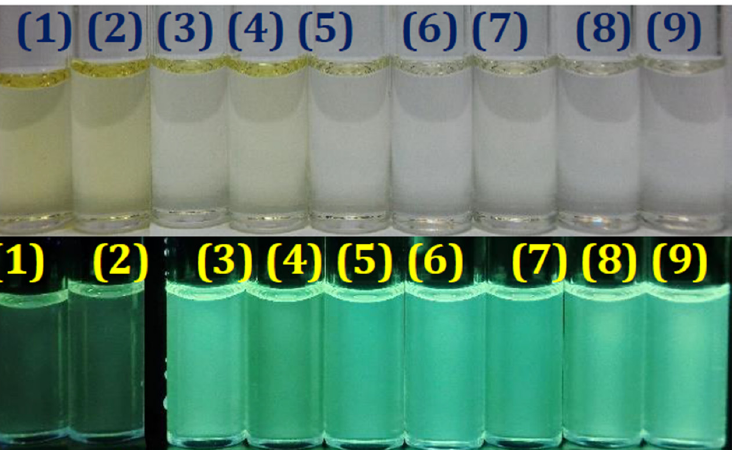
Figure 12. From left to right: (1) reference 1 (1.68 × 10 − 5 M in DMSO); (2) reference + air (bubbled); (3) reference + fish sample (bubbled) (3 days at 25 ◦ C); (4) reference + fish sample (bubbled) (1 day at 25 ◦ C); (5) reference + histamine (bubbled); (6) reference + putrescine (bubbled); (7) reference + cadaverine (bubbled); (8) reference + pyrrolidine (bubbled); (9) reference + all amines (bubbled). (Top) Under visible light; (Bottom) under UV light (366